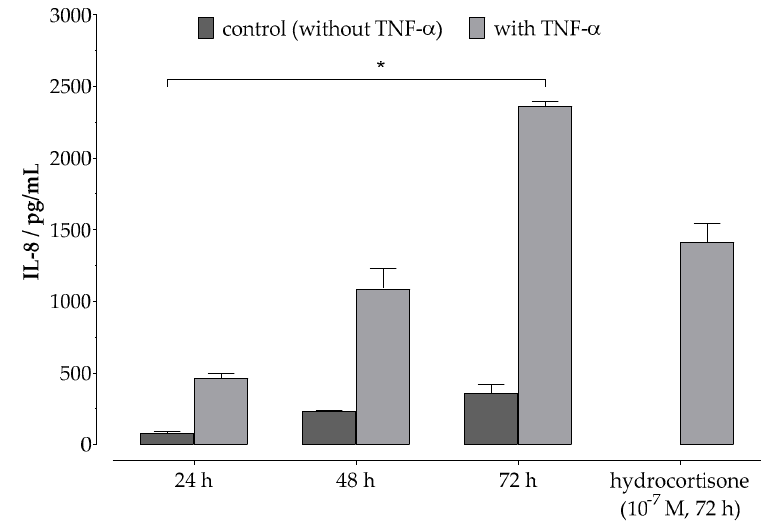
Figure 2. Pre-studies for Interleukin-8 (IL-8) release of HaCaT cells after treatment with 10 ng/mL TNF- α as a function of incubation time and treatment with hydrocortisone (10 − 7 M) for 72 h. MW ± SD, n = 3, *p ≤ 0.05 (each in triplicates).